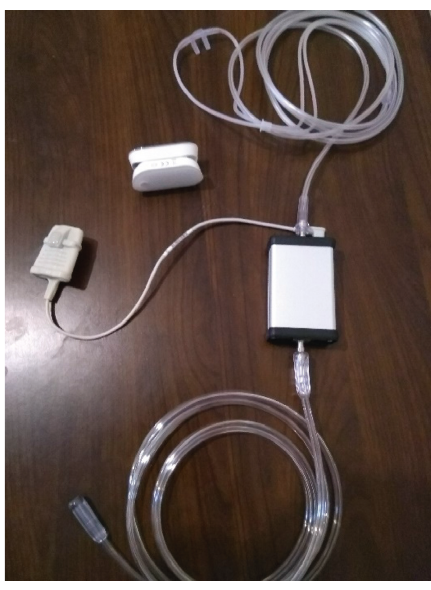
Figure 1: Digital Oxygen Therapy